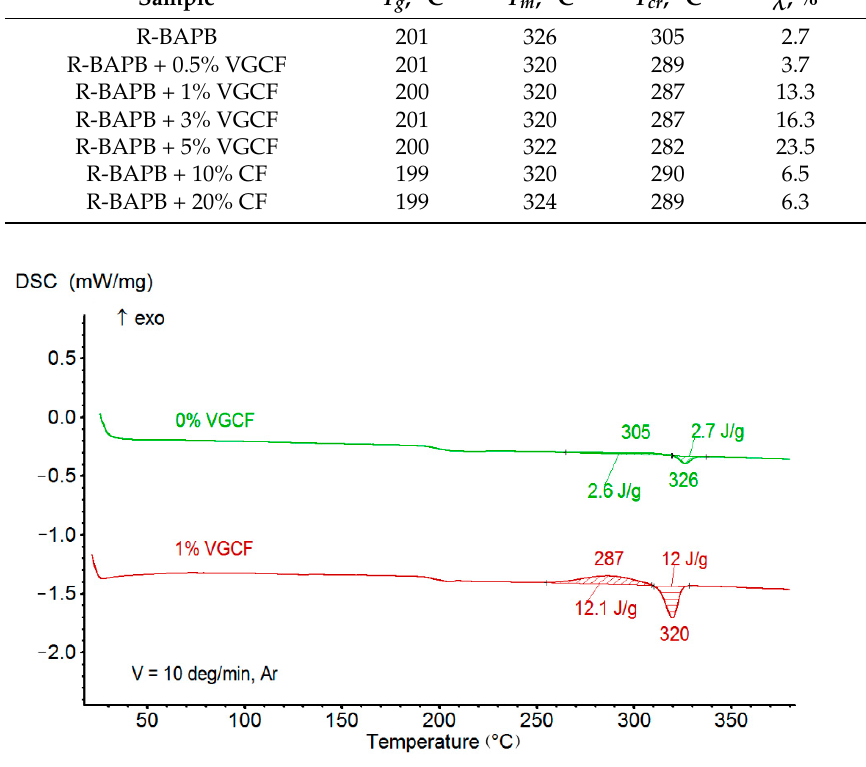
Figure 4. An example of the effect of VGCF on phase transitions in R-BAPB-based composites.